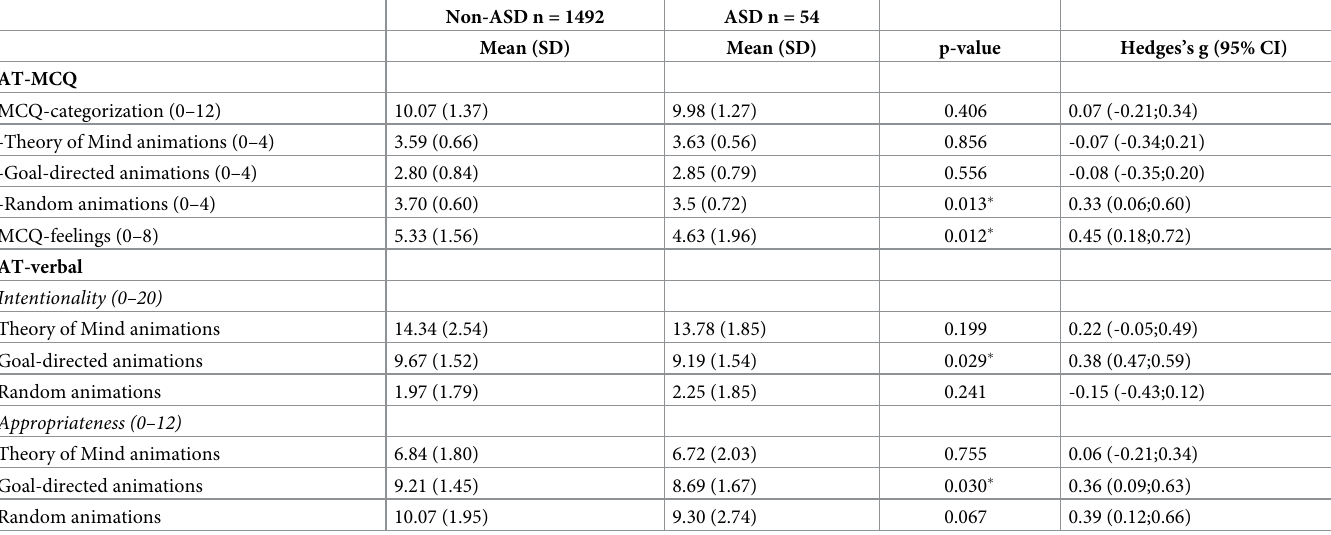
Table 6. Comparison of animated triangles scores between adolescents with and without diagnoses of autism spectrum disorder